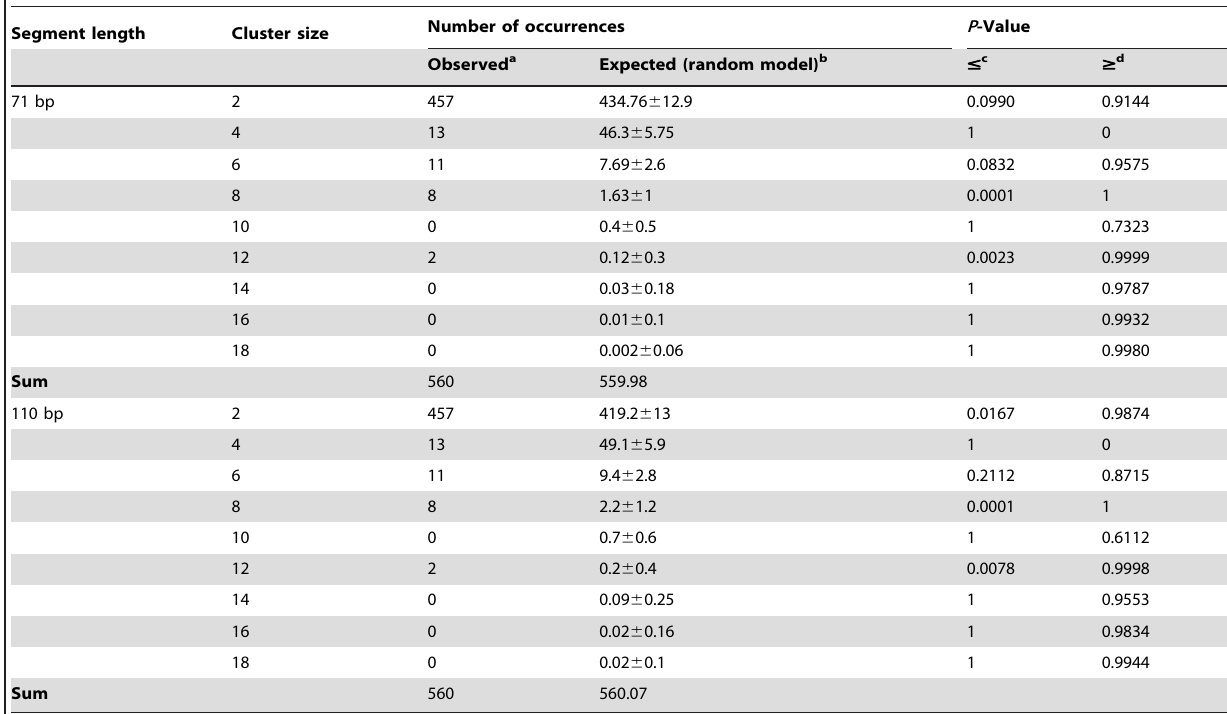
Data are the frequency of REP clusters (from doublets to cluster of 18 REPs) found in extragenic space compared to a null model based on the random assignment of 560 6 71 bp and 560 6 110 bp segments (to extragenic space). REP clusters containing an uneven number of REP sequences are included in the next lower cluster size (REP singlets are omitted). a Observed occurrences from the SBW25 genome. b